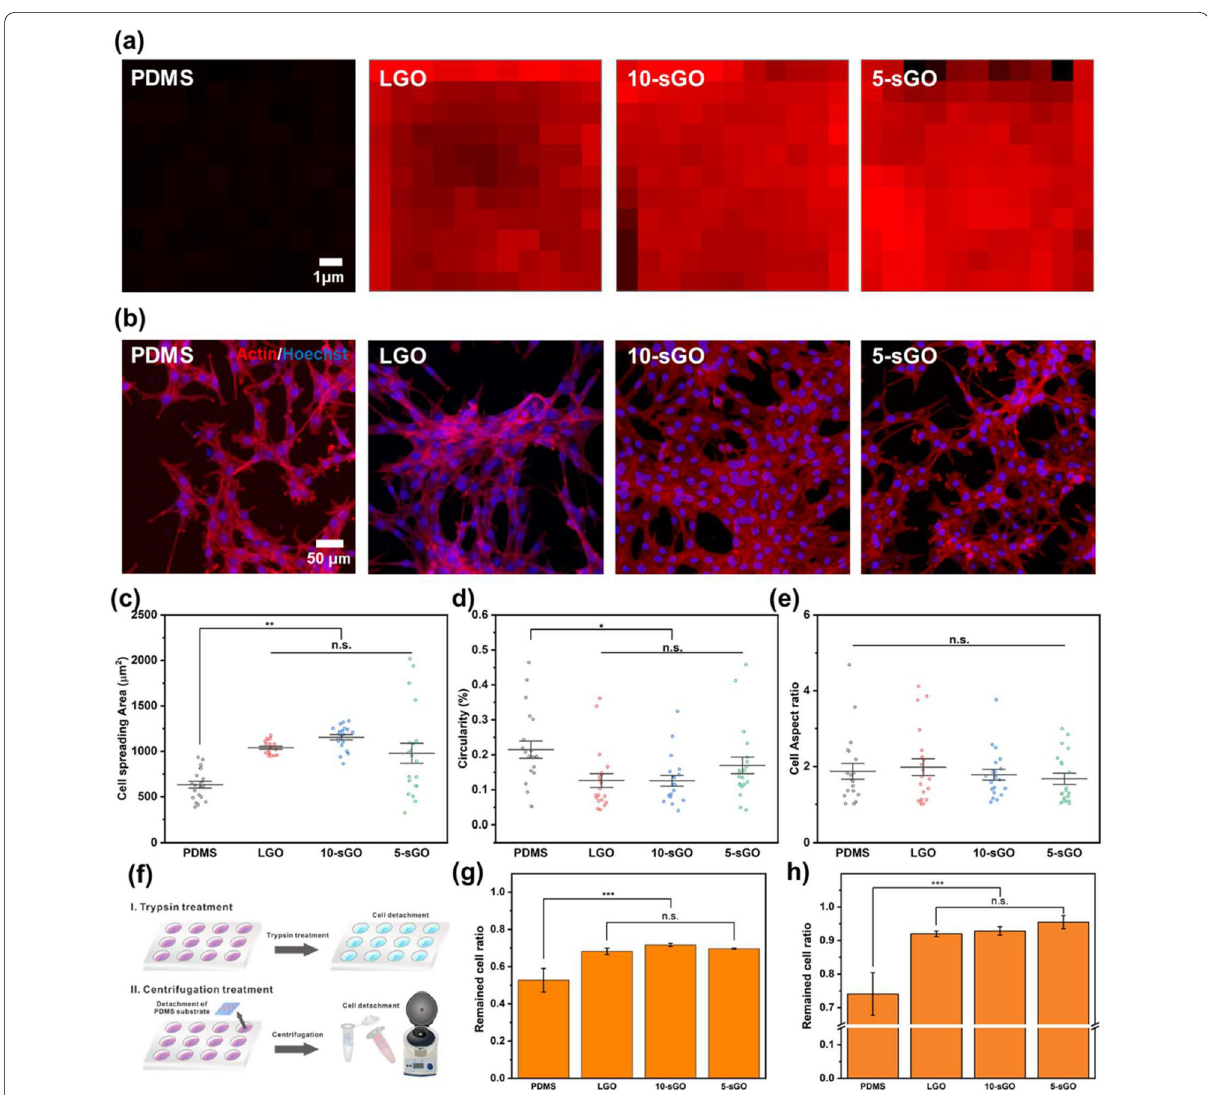
Fig. 3 Confirmation of the effect of graphene oxide on cell behaviors. a FE‑SEM images of PR nanohole patterns and PDMS nanopillar patterns, and b size distribution of PDMS patterns. Raman intensity map of the bare PDMS, LGO‑, 10‑sGO‑, and 5‑sGO‑modified PDMS. b Confocal microscope images of the cells on bare PDMS, LGO‑, 10‑sGO‑, and 5‑sGO‑modified PDMS immunostained with actin (Red) and Hoechst (Blue). c spreading area ( c ), circularity ( d ), and cell aspect ratio ( e ) of the cells on bare PDMS, LGO‑, 10‑sGO‑, and 5‑sGO‑modified PDMS. f Schematic diagram of trypsin and centrifugation treatment process. g , h Cell ratio remaining on the PDMS, LGO‑, 10‑sGO‑, and 5‑sGO‑modified PDMS after trypsin ( g ) and centrifugation ( h ) treatment. (* p 0.5, ** p 0.01, *** p ≤ ≤ ≤